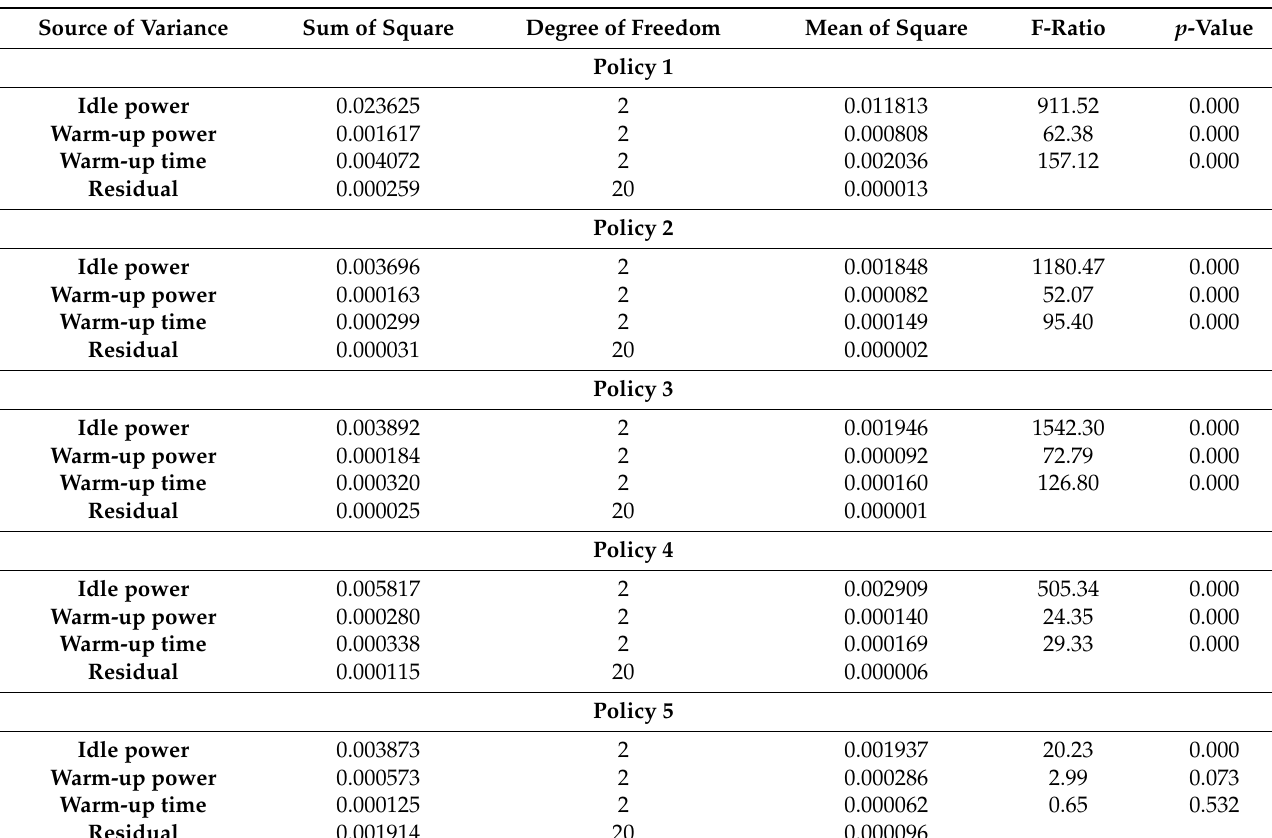
Figure 7. Time delay for unit of product. Table 5. ANOVA